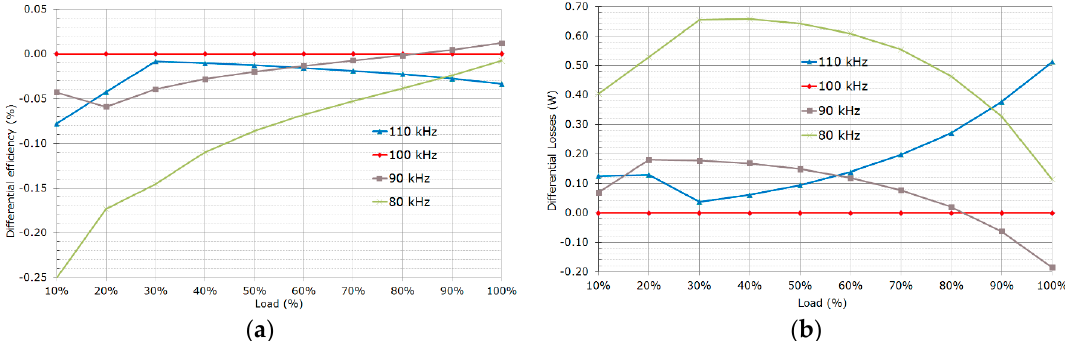
Figure 17. Performance comparison for different switching frequencies: ( a ) differential efficiencies; ( b ) differential losses.